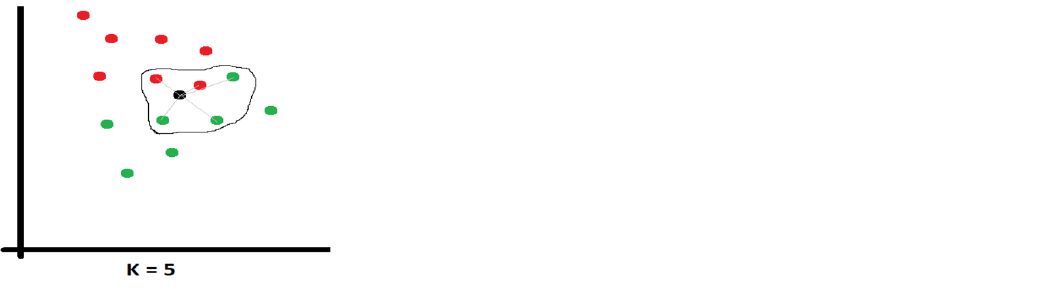
Figure 10. Weighted KNN